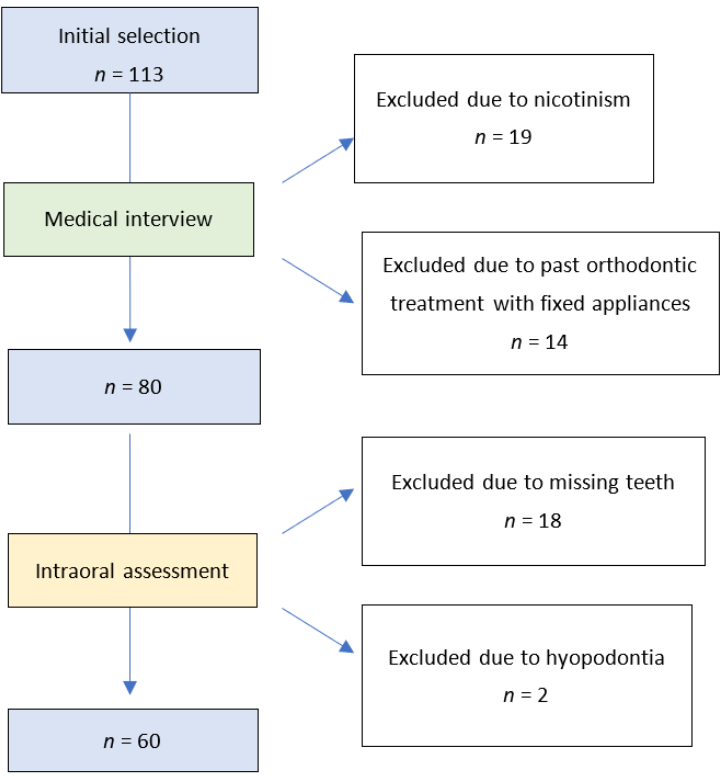
Figure 1. Flowchart of the study material selection.